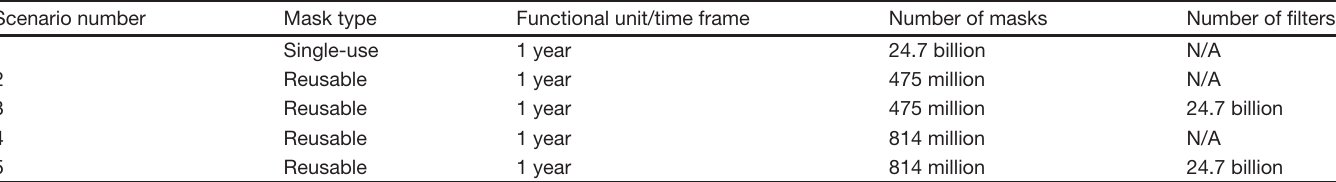
The assumed UK population was 67.8 million [68].